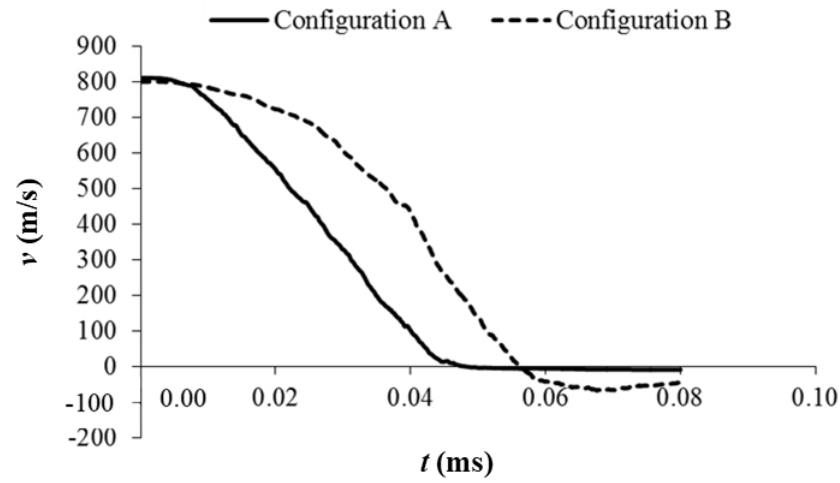
Figure 14. Projectile velocity as a function of time for each plate at initial velocity of 800 m/s.